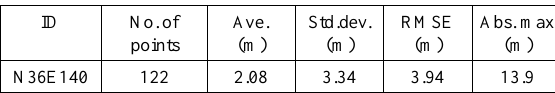
Table 5. Stats of height difference between the DSM tile and GCPs (DSM minus GCP)